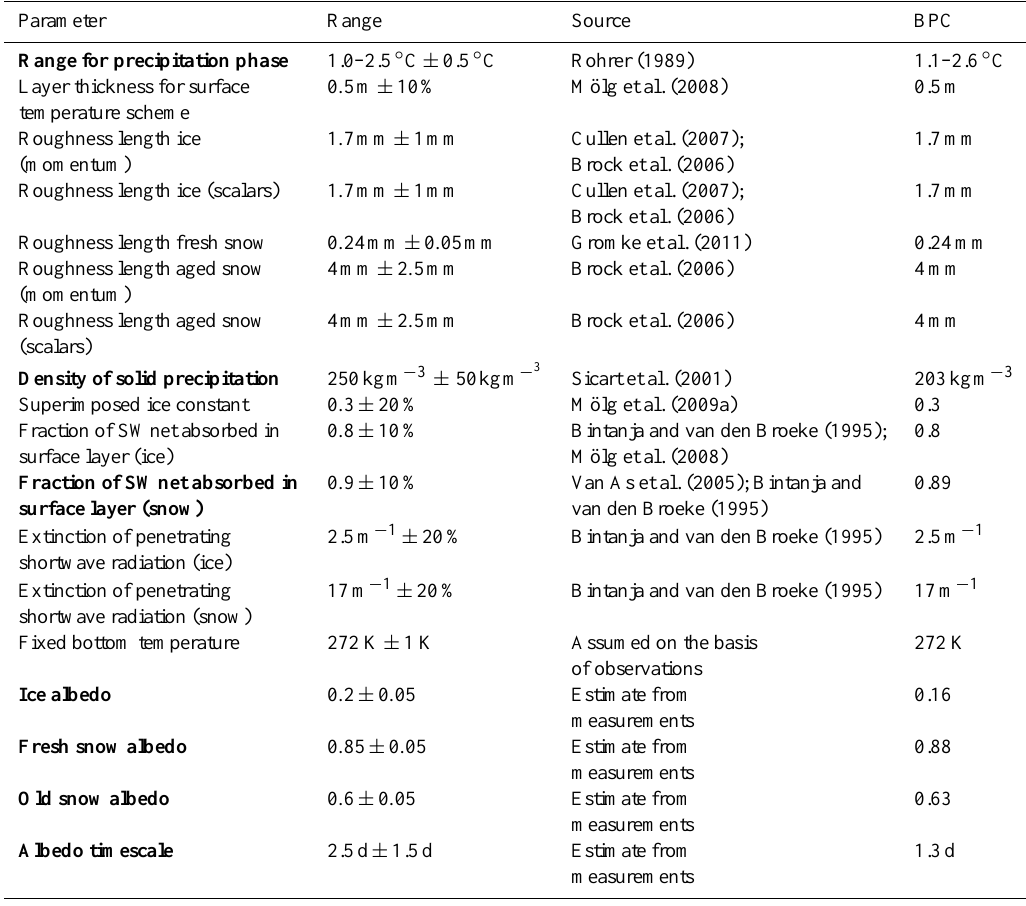
Table A1. List of free model parameters for the selected model design based on Mölg et al. (2012) and Gurgiser et al. (2013). The given range is applied in the sensitivity analysis (Sect. 2.2.2). Parameters that change cumulative mass balance by more than ± 10% in our sensitivity test (Sect. 2.2.2) are highlighted in bold. The final values are the values in the best parameter combination (BPC) derived from the Monte Carlo approach (Sect. 2.2.3). The precipitation gradient in the spatial distributed model run is set to zero as we have no information on precipitation above AWS M (4950ma . s . l . ) at our study